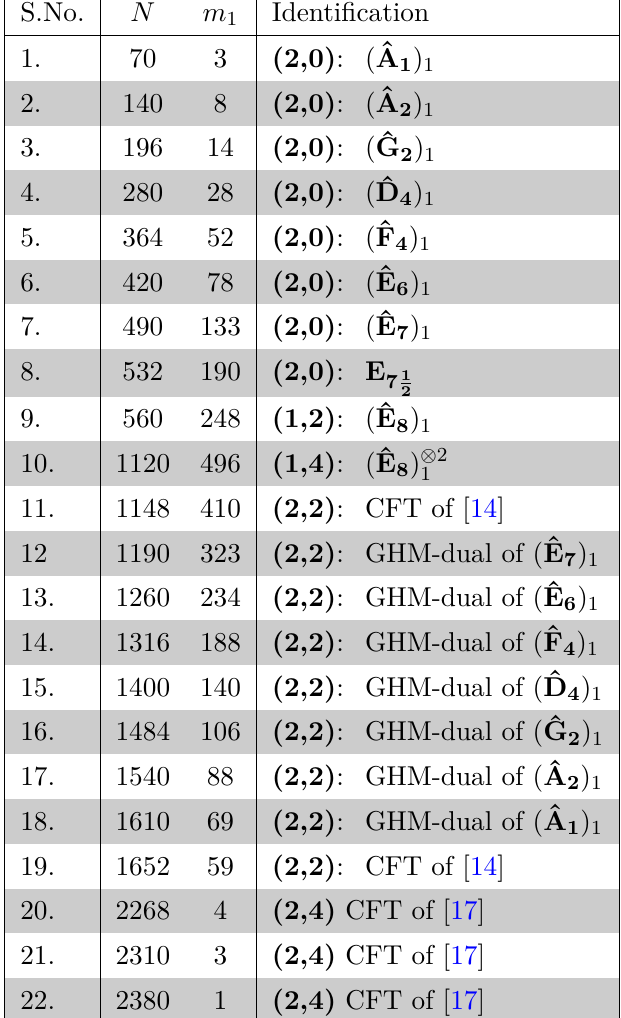
Table 7 . Category II